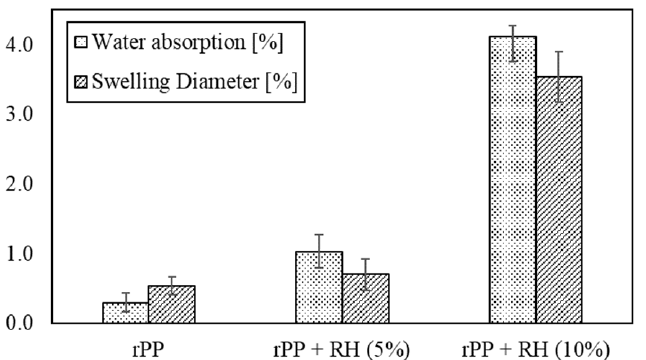
Figure 3. Water absorption and swelling diameter of rPP and rPP/RH composites. Thermal stability of RH fiber, neat rPP, rPP/RH (5 wt.%) and rPP/RH (10 wt.%) was studied by thermo-gravimetric analysis. Figure 4 shows the percentage weight change and the derivative of weight as a function of each material’s temperature. For the RH fibers, three stationary regimes are observed. A first phase ranging from 50 to 100 ◦ C is linked to the moisture content of the fiber, representing 10% of the weight; the second phase, with a significant decay at 280 ◦ C is related to the degradation of hemicelluloses and partial decomposition of lignin, and the third point at 340 ◦ C is associated with α -cellulose and remaining lignin degradation [108]. The observed thermal behavior of RH was similar to that of other lignocellulosic fibers [19,29,109]. For the rPP curves, a small weight change is observed between 165 and 175 ◦ C, attributed to impurities’ presence due to the recycled nature of the polymer. Moreover, between 400 to 490 ◦ C a main step is associated with the main degradation of the polypropylene. rPP/RH (5 and 10 wt.%) curves present combined loss behavior. The first step ranging from 50 to 120 ◦ C is attributed to the evaporation of moisture. The next two steps represent the fiber components degradation, and the last represents the matrix degradation at 460 ◦ C. Finally, for RH and rPP/RH (5 and 10 wt.%) composites, the residual mass percentage at 600 ◦ C was around 34.45%, 3.52%, and 3.88%, respectively.